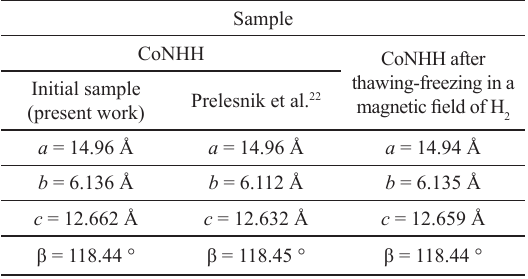
Table 3. Lattice parameters of initial sample of CoNHH and CoNHH after thawing-freezing in a magnetic field of H corresponding data from reference 22 .